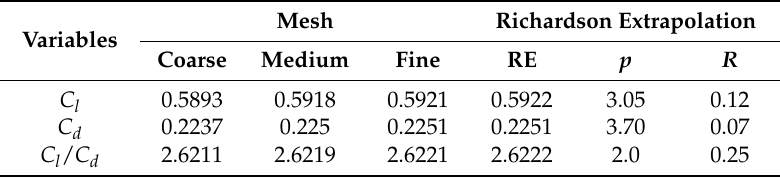
Table 3. Results of the grid independence